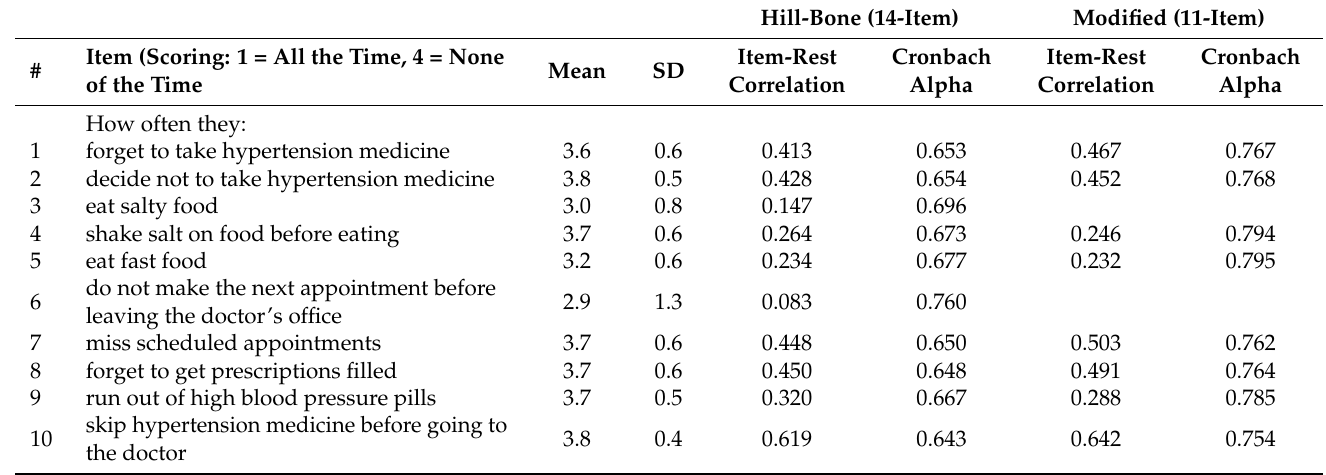
Table A1. Hill-Bone medication adherence summary statistics and